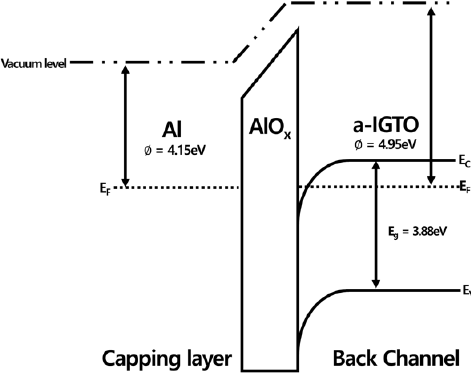
Figure 7. Schematic energy band diagram for the Al-AlO X -Si MOS capacitor.